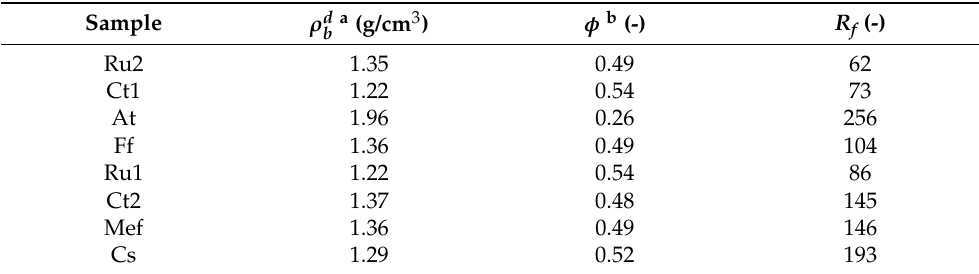
), porosity ( φ ), and retardation factor ( R f b